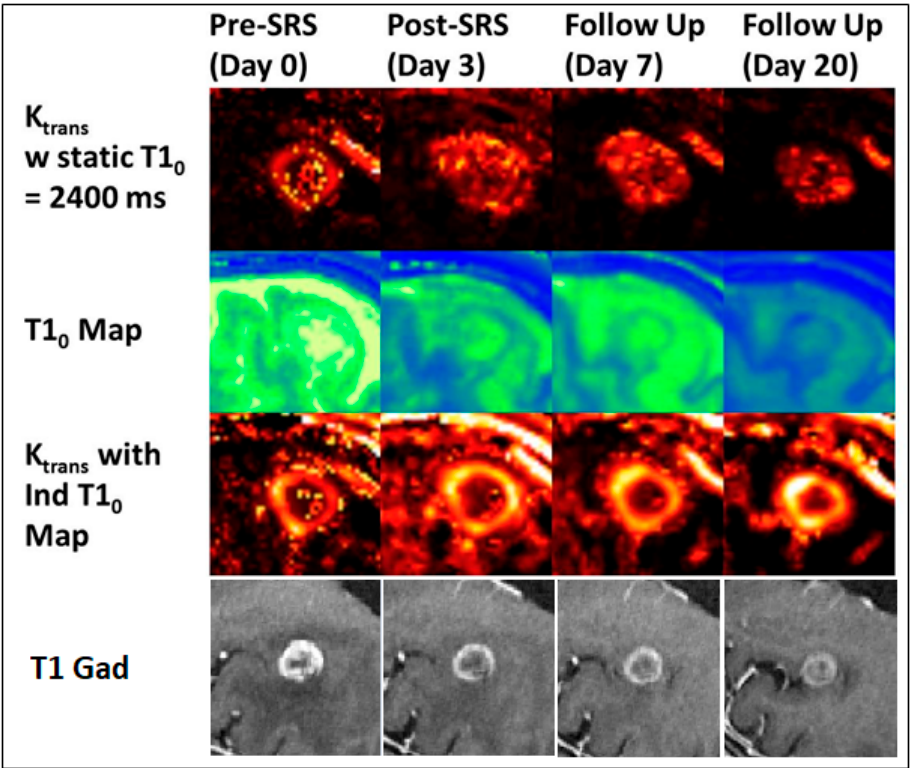
Figure 2. Central section through a brain metastasis for the same patient over different imaging days showing ( top ) K trans values using a static T10 map, ( middle ) the voxel-based T10 map, and ( bottom ) K trans values using the individual T10 map [37].